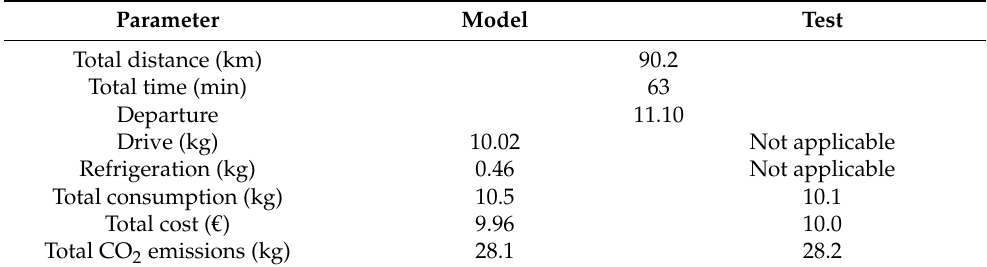
Table 1. Comparison between measured data and results obtained from the model. Parameter Model Test Total distance